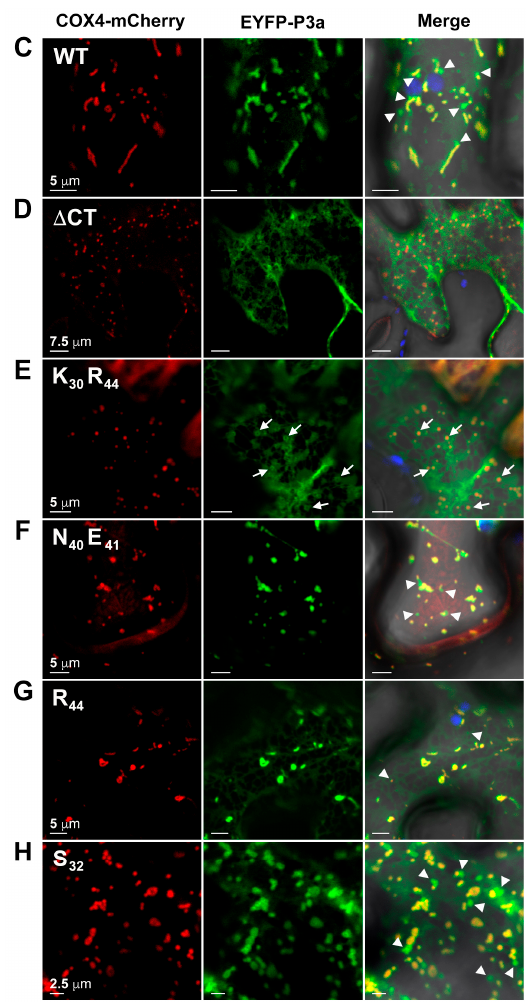
Figure 9. Mutational analysis of the C-terminus of PLRV P3a validates its role in directing mitochondrial localization in planta . ( A ) Weblogo alignment of the C-terminal residues of the P3a protein downstream of the predicted transmembrane domain (TMD) from 34 luteovirid species. The height of the stack denotes sequence conservation while the height of the symbol indicates the relative frequency of that amino acid at that position in PLRV P3a. Basic residues are red, acidic in green, and hydrophobic residues in blue; ( B ) Position and identity of the EYFP-P3a C-terminal truncation ( Δ CT) and four alanine substitution mutants compared to WT. The amino acid changes are in red and the numbers indicate the amino acid position in PLRV P3a. Only the last five amino acids of the TMD and the 16 residues of the P3a C-terminus in the fusion protein are shown; ( C – H ) Panels show single-plane confocal micrographs of N. benthamiana leaf epidermal cells co-expressing WT or each of the EYFP-P3a C-terminal mutants (green) with the mitochondrial marker COX4-mcherry (red). The overlap of EYFP and mCherry fluorescence with the corresponding brightfield image is shown in the column labeled Merge with co-localization of fluorescence appearing yellow. Chloroplast autofluorescence is highlighted in blue. White arrowheads indicate MVDs. White arrows label ER-derived ring structures surrounding COX4-mcherry-labeled mitochondria. Scale bars show the length indicated.